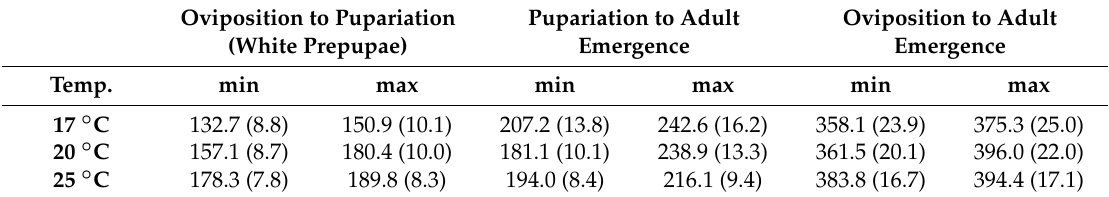
Table 1. Minimum (min) and maximum (max) development periods in accumulated degree days (ADD) and in (days) of Calliphora vicina during this study. For ADD calculation, a constant lower development threshold of 2 ◦ C for all three rearing temperatures was assumed [32].